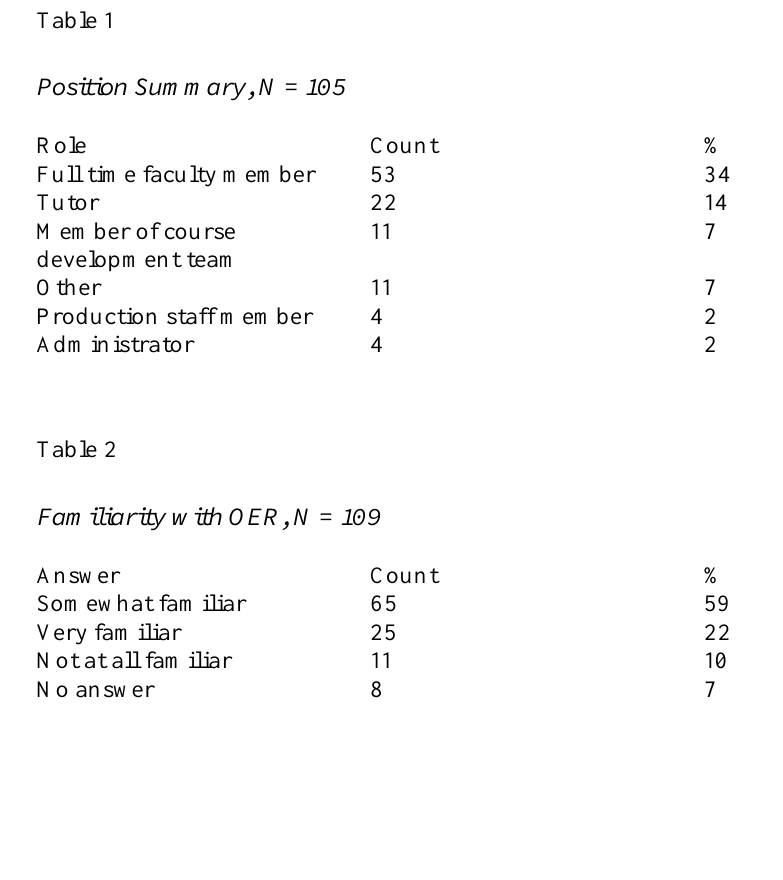
Position Summary, N = 105